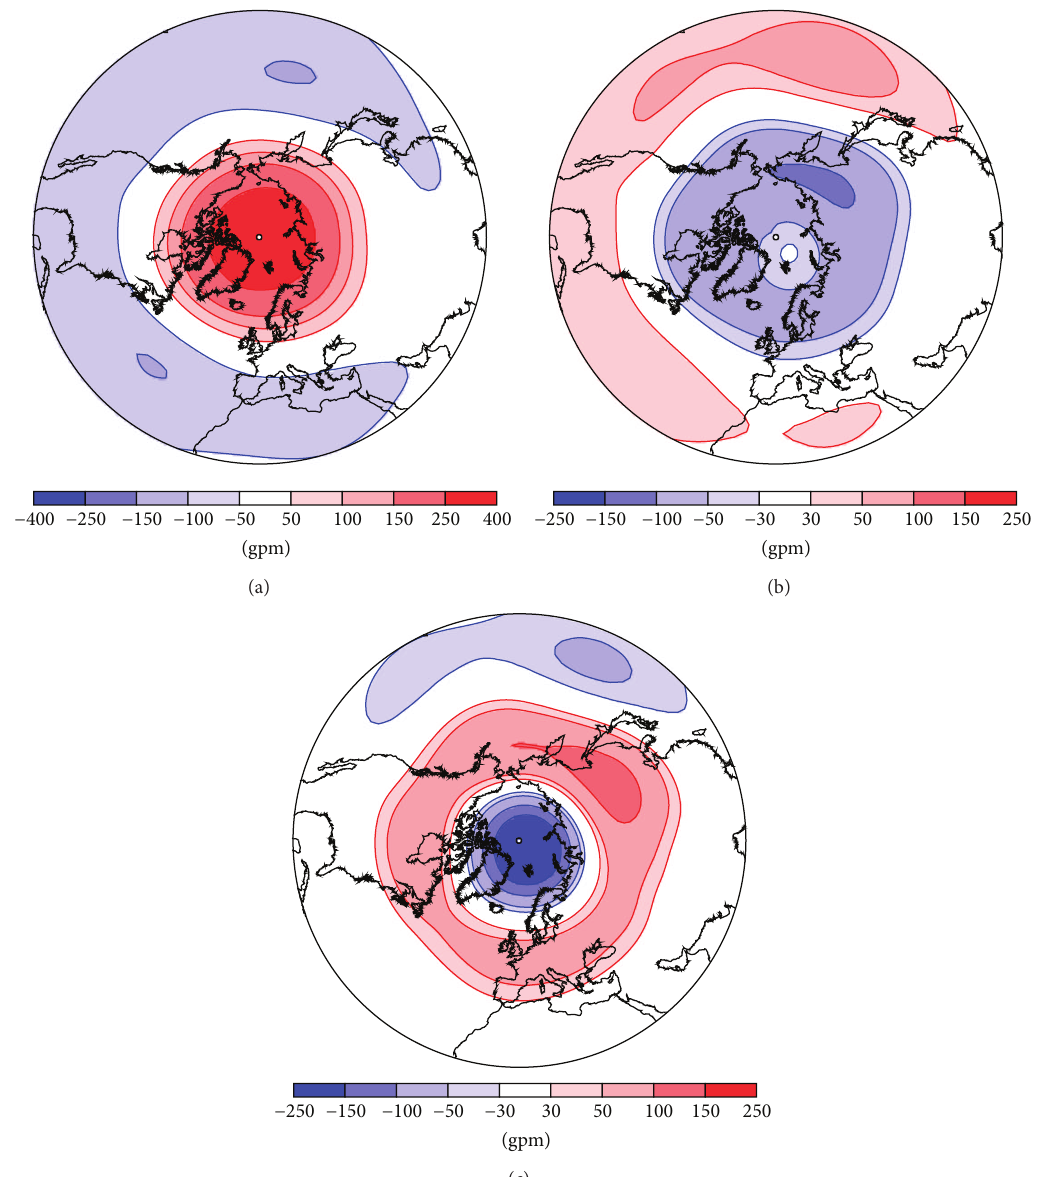
Figure 15: Composite geopotential height (gpm) anomaly patterns of the modeled regimes of experiment II (areas A–C in Figure 13 right) at the 833 hPa